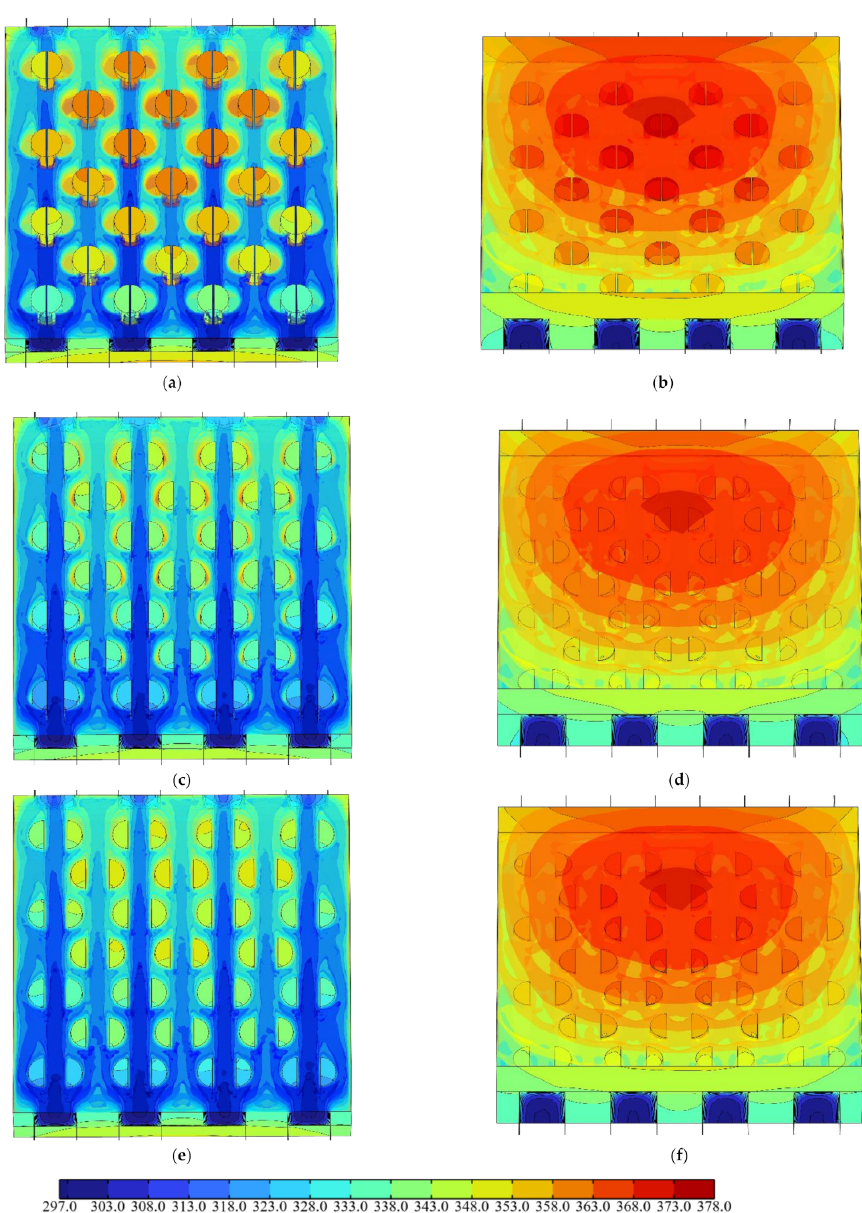
Figure 10. Temperature color maps of hotspot area of the hybrid heat sink with different L fin (unit K). ( a ) L fin = 10 µ m (top view). ( b ) L fin = 10 µ m (bottom view). ( c ) L fin = 100 µ m (top view). ( d ) L fin = 100 µ m (bottom view). ( e ) L fin = 140 µ m (top view). ( f ) L fin = 140 µ m (bottom